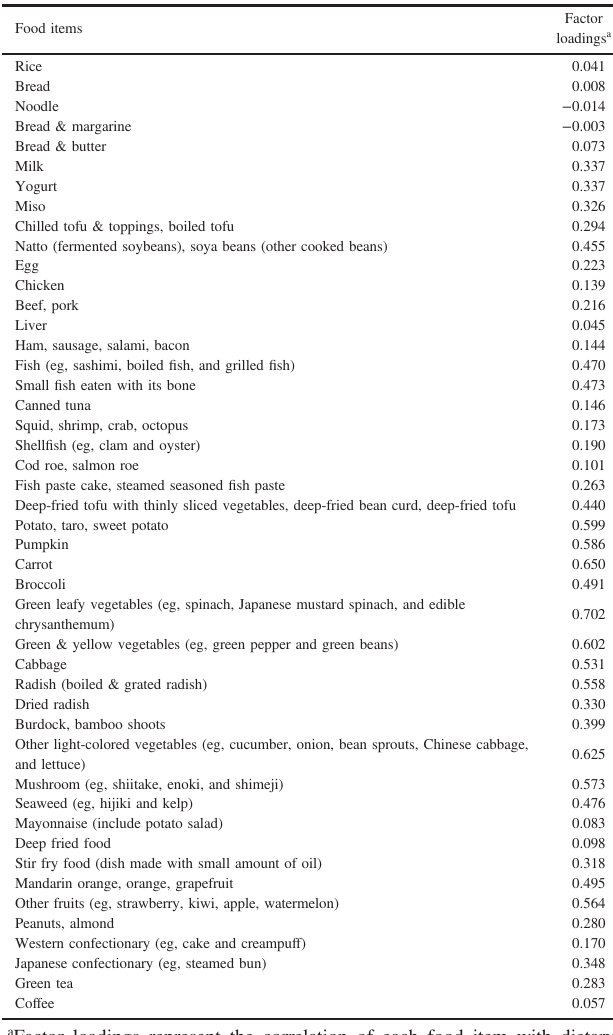
a Factor loadings represent the correlation of each food item with dietary pattern 1